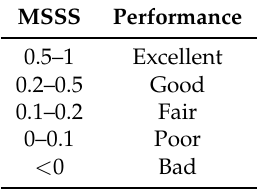
Table 1. Mean Squared Skill Score (MSSS) model performance as given by Sutherland et al. [32].